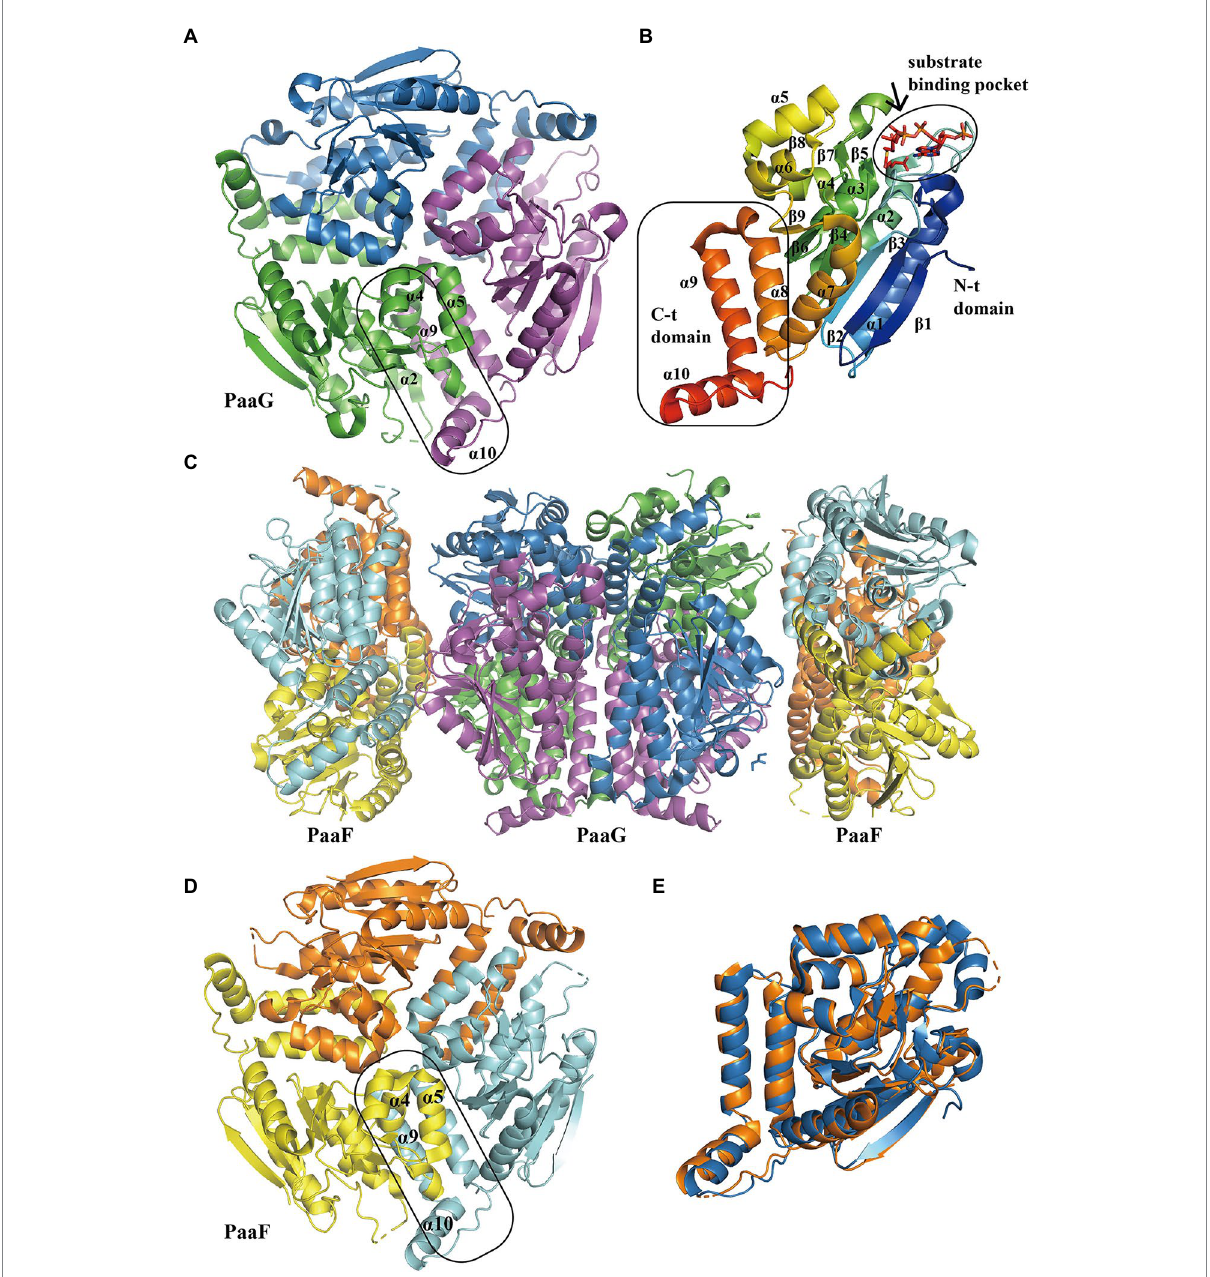
FIGURE 5 Overall structure of PaaG and PaaF. (A) The overall structure of trimer TthPaaG (PDB:6SLB). The interface is circled with a solid line. The different chains are shown in blue, violet, and green, respectively. (B) The secondary structure elements in PaaG monomer with the substrate trans-3,4- didehydroadipyl-CoA binding in N-spiral domain. The N-terminal and C- terminal domains are circled with a solid line. The monomer is colored as the rainbow and the substrate is shown as sticks. (C) The overall structure of EcoPaaFG complex (PDB:4FZW). The dimer of trimer PaaG is covered with two PaaF trimers. PaaF chains are shown in orange, yellow, and cyan, and PaaG is shown in the same colors as in (A) . (D) The overall structure of trimer PaaF, reveals a similar shape and interaction site as PaaG trimer as PaaG. (E) The structure alignment between PaaF and PaaG monomer reveals a similar crotonase fold